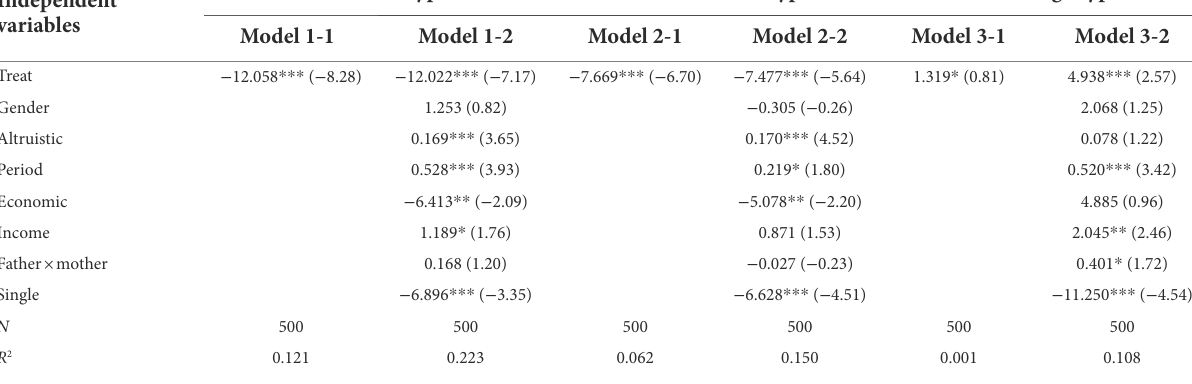
TABLE 5 Individual investment with or without leaders. Independent